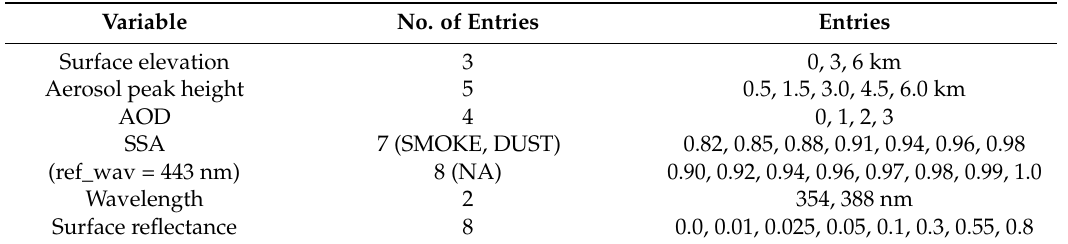
Table 2. Considered Parameters for LUT to Retrieve the Theoretical Value of SAI and UVAI using VLIDORT. SZA, RAA, and VZA are fixed to 36 ◦ , 150 ◦ , and 38 ◦ ,